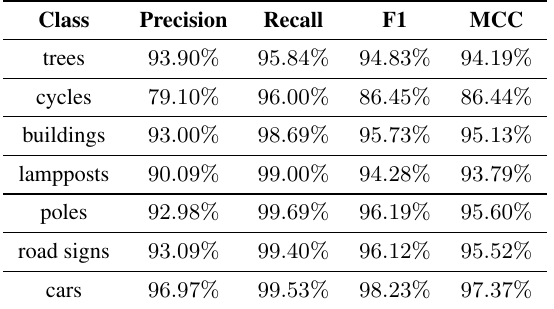
Table 2: Mean Precision, Recall, F1 and MCC scores for each class